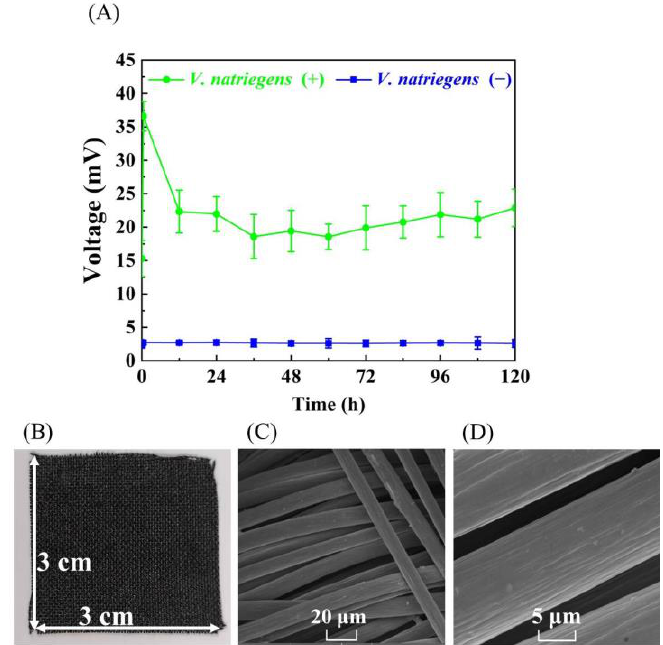
Figure 3. Evaluating the bioelectricity production capacity of V. natriegens by MFC without adding exogenous electron mediators. ( A ) External circuit voltage of LB3 MFC inoculated and uninoculated with V. natriegens (control group). The anode and cathode electrodes were connected through an external resistance of 1 kΩ. (+): inoculated with V. natriegens ; ( − ): uninoculated with V. natriegens . ( B ) photo of carbon cloth anode from V. natriegens LB3 MFC running for 120 h; ( C ) SEM photos of carbon cloth anode with magnification of 2000 times and ( D ) SEM photos of carbon cloth anode with magnification of 10,000 times using a TESCAN MAIA3 scanning electron microscope (SEM) (TESCAN, Brno, Czech Republic).